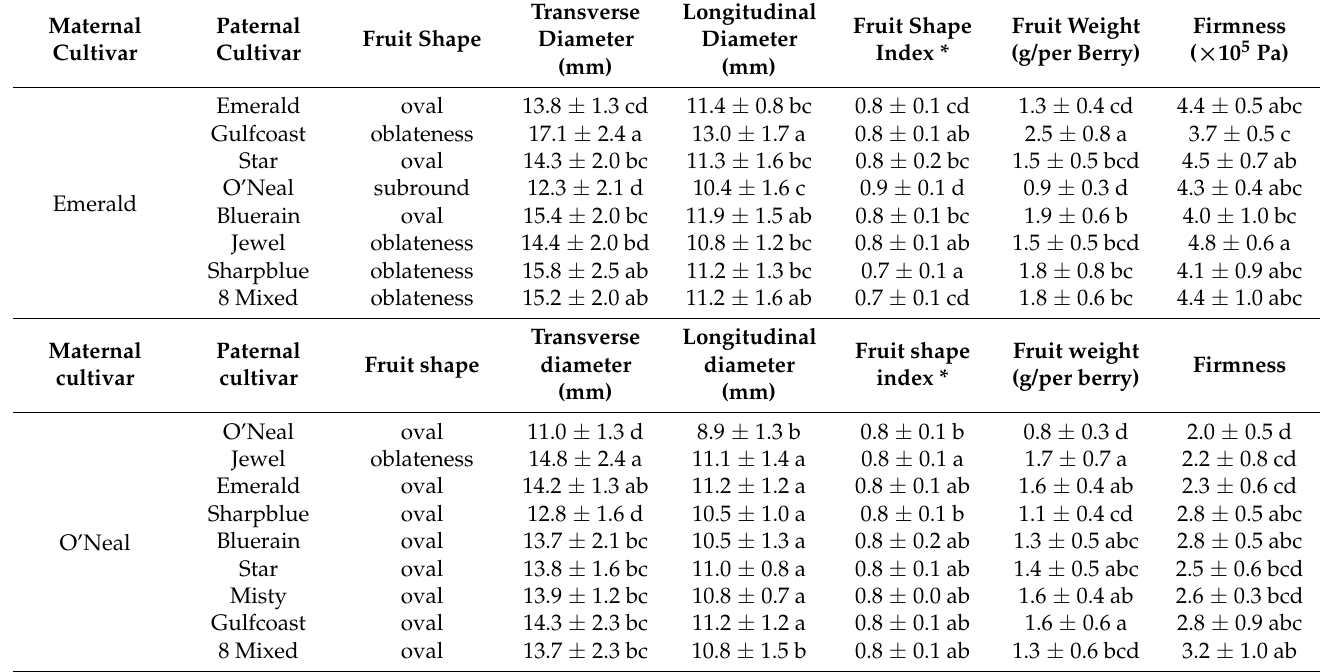
Table 1. Xenia effects on the appearance quality of SHB fruits.